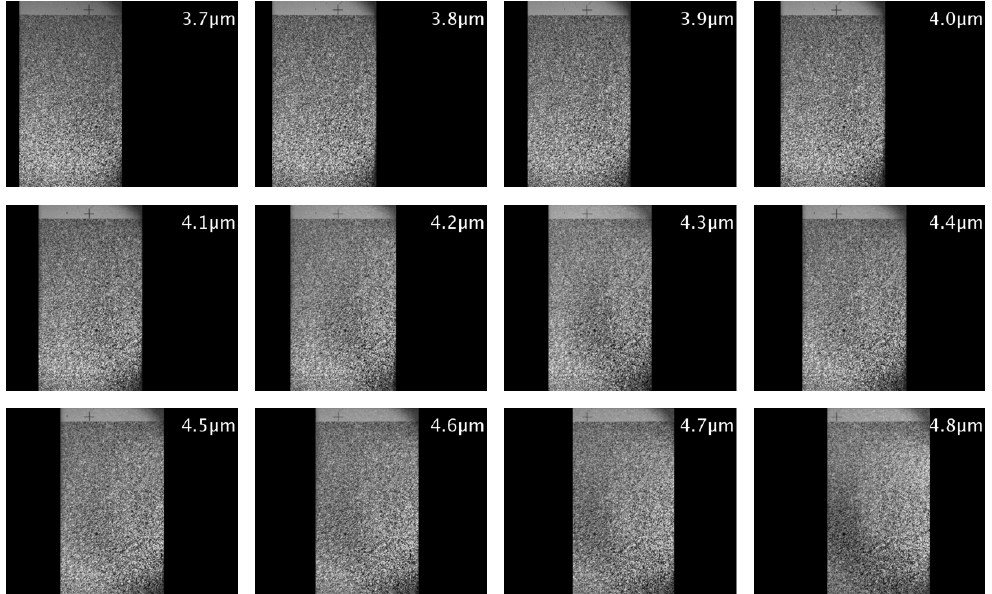
Figure 14. The MWIR-SCSI system response to uniform illumination of the coded mask at 11 different monochromatic wavelengths.